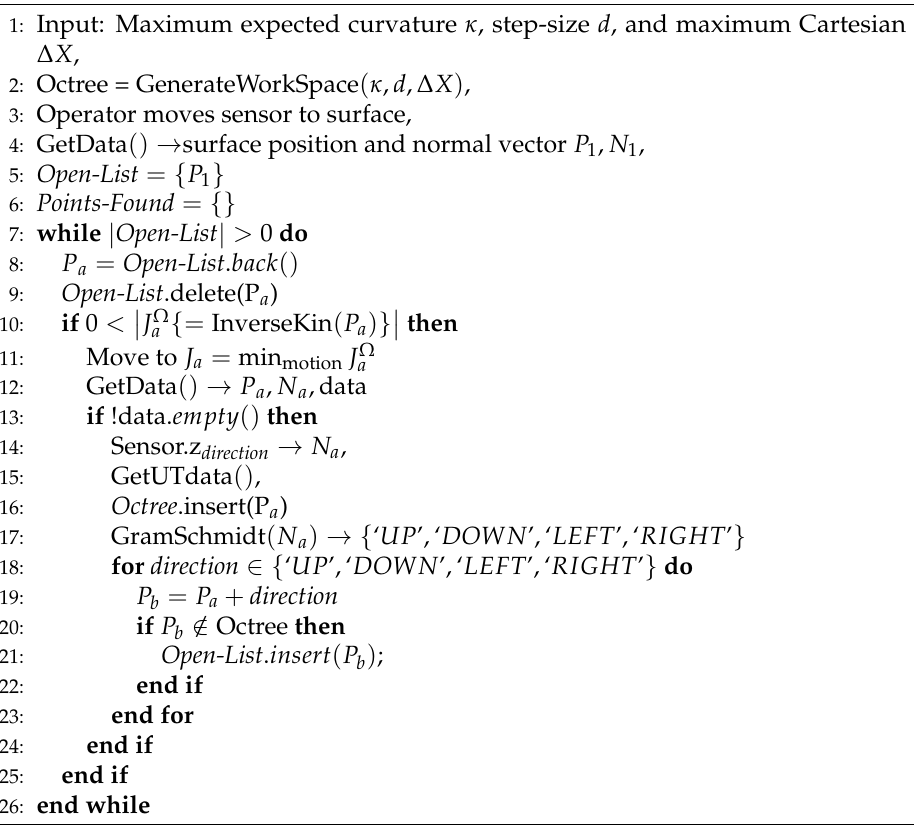
Algorithm 2 Pseudo-code for the novel